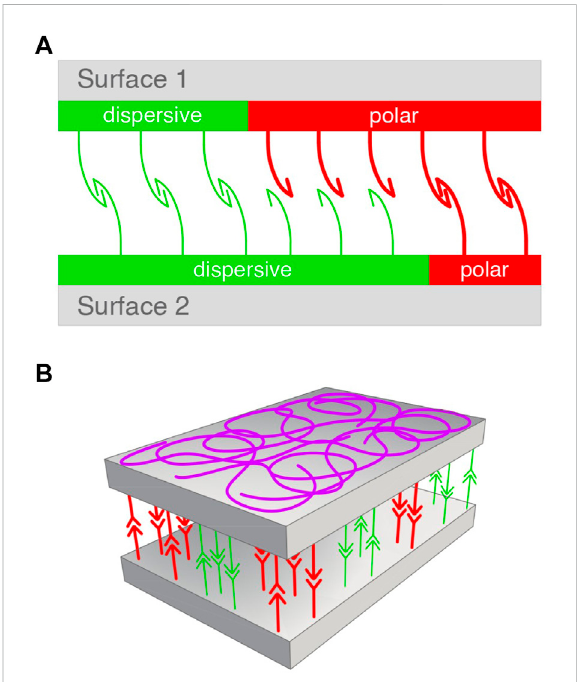
FIGURE 1 Modelsforsurfaceassociation. (A) Data-Physicsmodelbased on dispersive (green) and polar interactions (red) balanced between two surfaces (Eq. 8). Adapted from Dataphysics. (B) Presently suggested model based on balanced and randomly oriented weak interactions represented by the Flory ’ Huggins parameter(green),andastromgerbindingconstant(red)(Eq.5).All supramolecular bonds undergo dynamic scrambling (exchanging partners) under equilibrium conditions. Designer: Luca Galbusera,